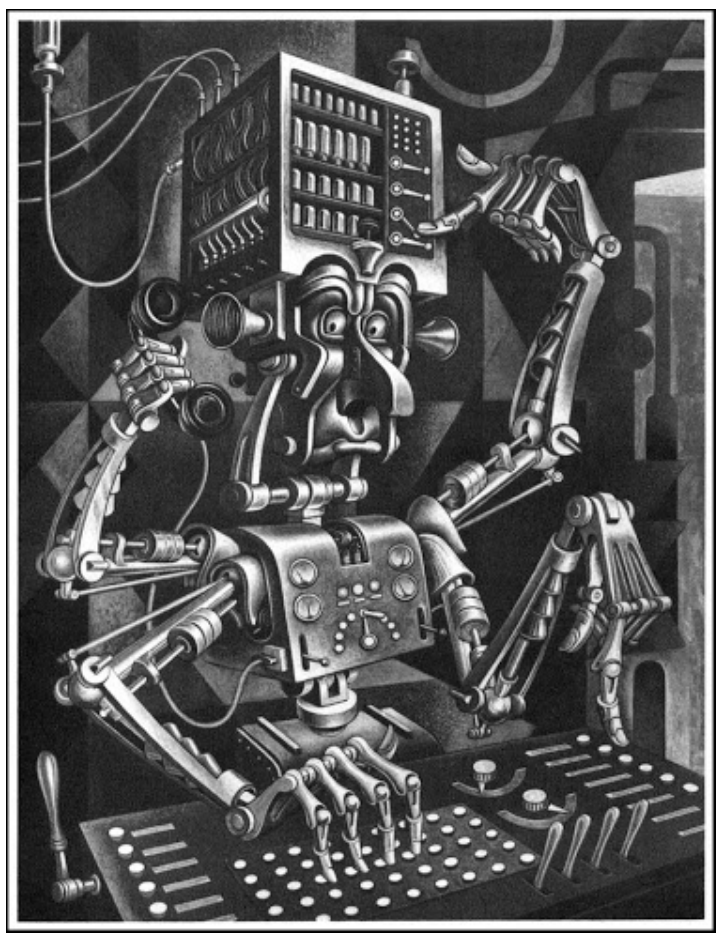
Figure 1. Boris Artzybasheff. “The Pocketa, Pocketa School”. Time , 25 May 1962 ([1], p. 99).